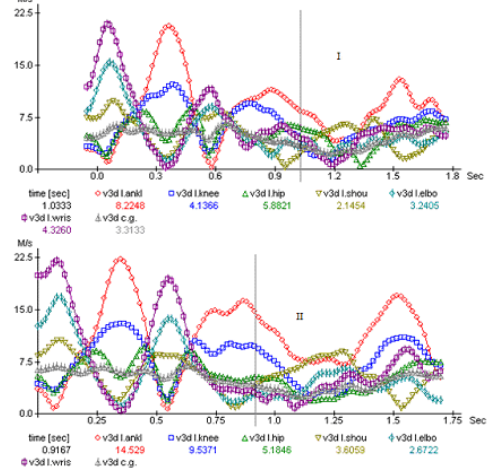
Fig. 3. Phase of main movements of acrobats, who fulfill first somersault at ascending part of flight trajectory in structure of double somersault, Key element of sport technique – MP ―grouping ‖ (tested A, variant 1, time 1. 033 sec.), and MP ―arching with insignificant bending in hip joints (tested B, variant 2, time 0. 917 sec.)